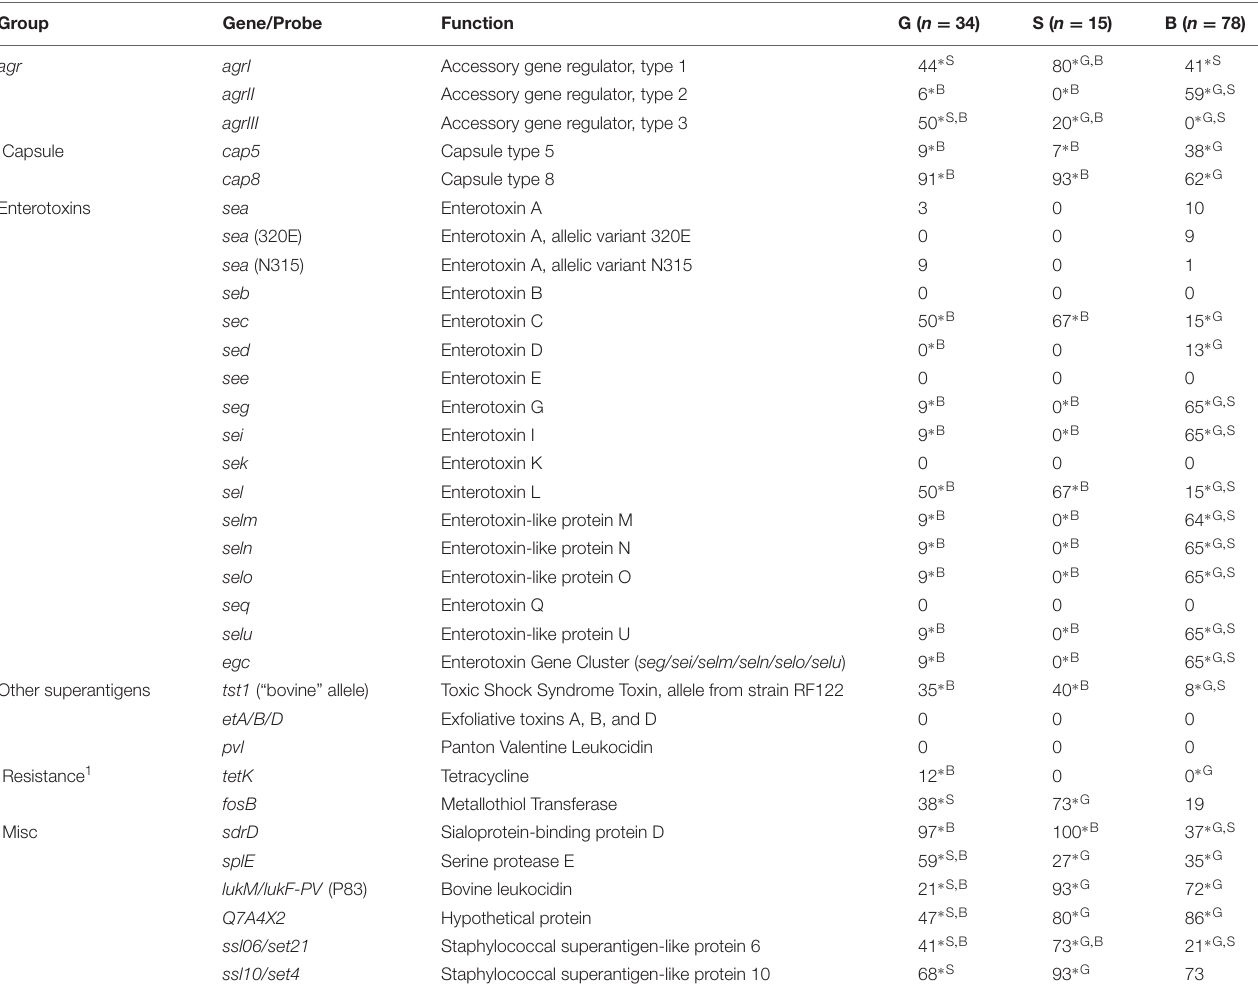
TABLE 1 | Prevalence rates of selected virulence and resistance genes detected among Staphylococcus aureus strains isolated from goat (G), sheep (S), and bovine (B) milk samples. Group